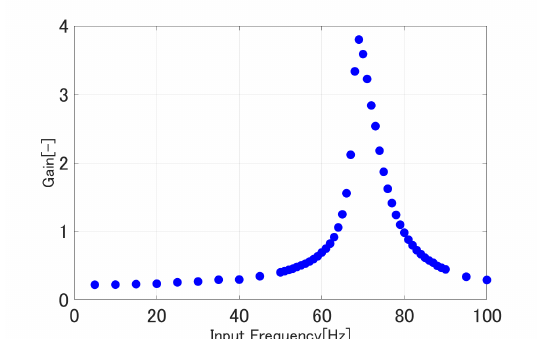
Figure 7. Frequency response characteristics of the bimorph piezoelectric actuator used in this study. It was measured experimentally using a pure sinusoidal input whose frequency was altered from 1 Hz to 100 Hz. It can be seen that this actuator has mechanical resonance at approximately 70